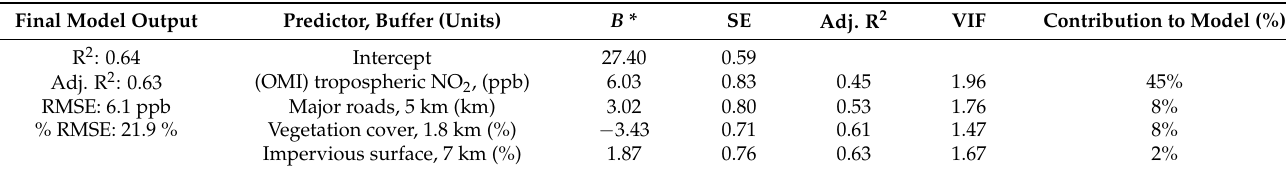
Table 2. Summary of final LUR